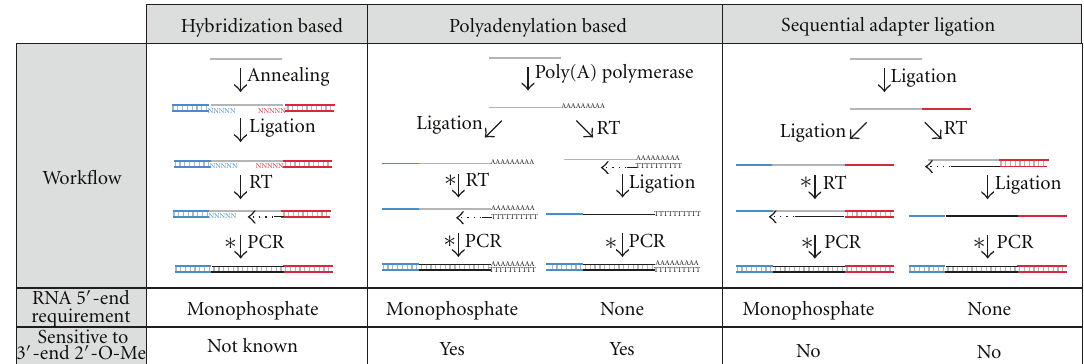
Figure 2: Small RNA high-throughput sequencing library construction methods. The 5 (cid:3) - and 3 (cid:3) -adapters are shown as blue and red lines, respectively. sRNAs are depicted as grey lines. After sRNAs are converted into DNA, the sequences are shown as black lines. The asterisks represent steps suitable for introducing barcodes in each method. The dashed lines with arrows illustrate cDNA synthesis. At the bottom of each schematic diagram, RNA 5 (cid:3) -end requirement and sensitivity to 2 (cid:3) -O-methyl modification at the 3 (cid:3) -end for each method are